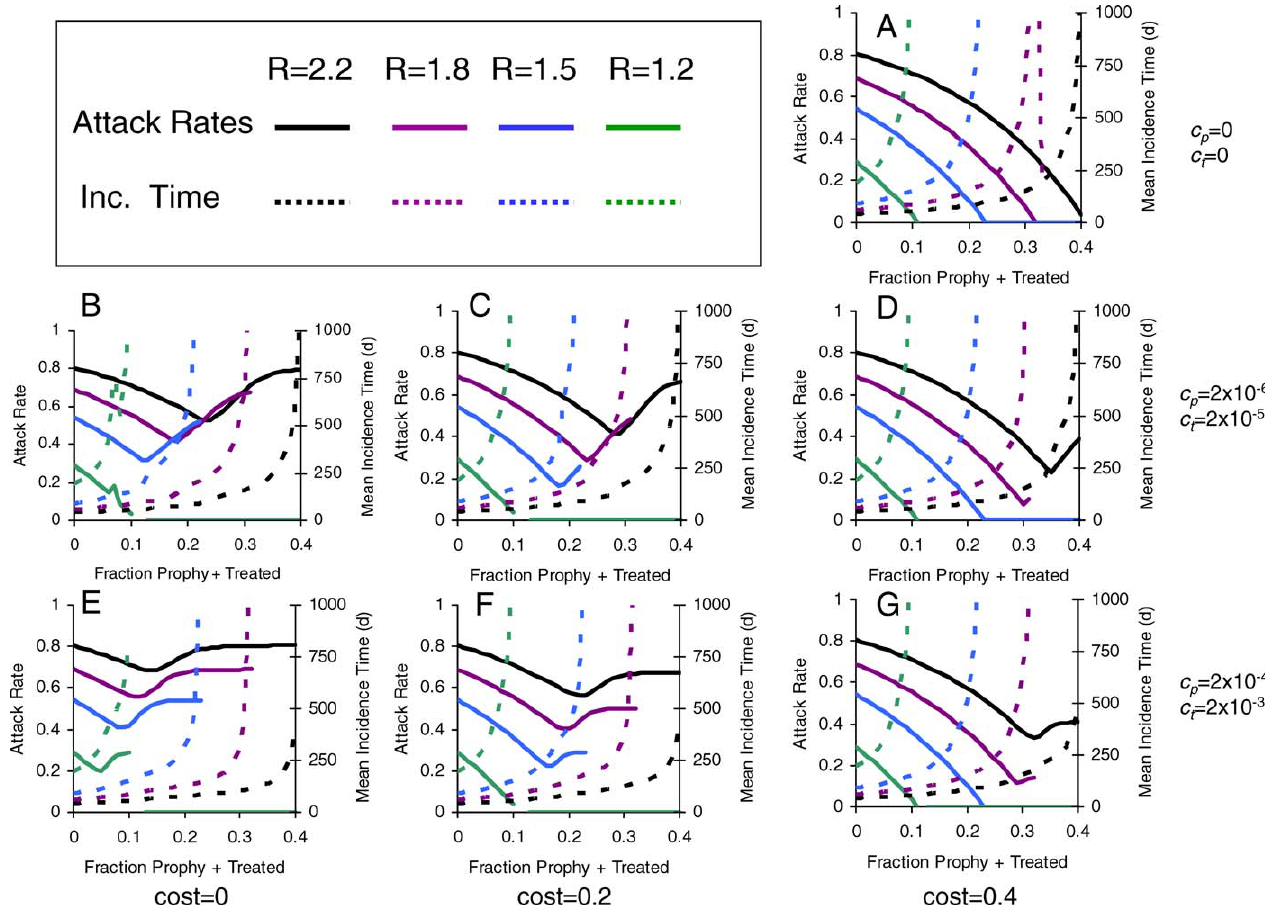
Figure 4. Effect of Varying Effective Reproductive Numbers (R E ) and of Antiviral Use on Total Attack Rate (Solid Curves) and Mean Incidence Time (Dashed Curves) Mean incidence time ( ‘‘ Inc. Time ’’ ) is the mean time of infection of all infected persons over the course of the epidemic. Rows represent different frequencies with which resistance emerges during prophylaxis ( ‘‘ Prophy ’’ ) ( c p ¼ 0, 2 3 10 (cid:2) 6 , and 2 3 10 (cid:2) 4 ) and treatment ( c t ¼ 0, 2 3 10 (cid:2) 5 , and 2 3 10 (cid:2) 3 ); columns represent different fitness costs of resistance (0, 20%, and 40%). Since the resistant strain is not present at the start of the simulations, it does not appear when c p ¼ c t ¼ 0, hence its fitness cost is irrelevant. Graph (A) represents the case with no resistance. Graphs (B–D) represent the case when c p ¼ 2 3 10 (cid:2) 6 and c t ¼ 2 3 10 (cid:2) 5 at a fitness cost of 0, 0.2, and 0.4, respectively. Graphs (E–G) represent the case when c p ¼ 2 3 10 (cid:2) 4 and c t ¼ 2 3 10 (cid:2) 3 at a fitness cost of 0, 0.2, and 0.4,